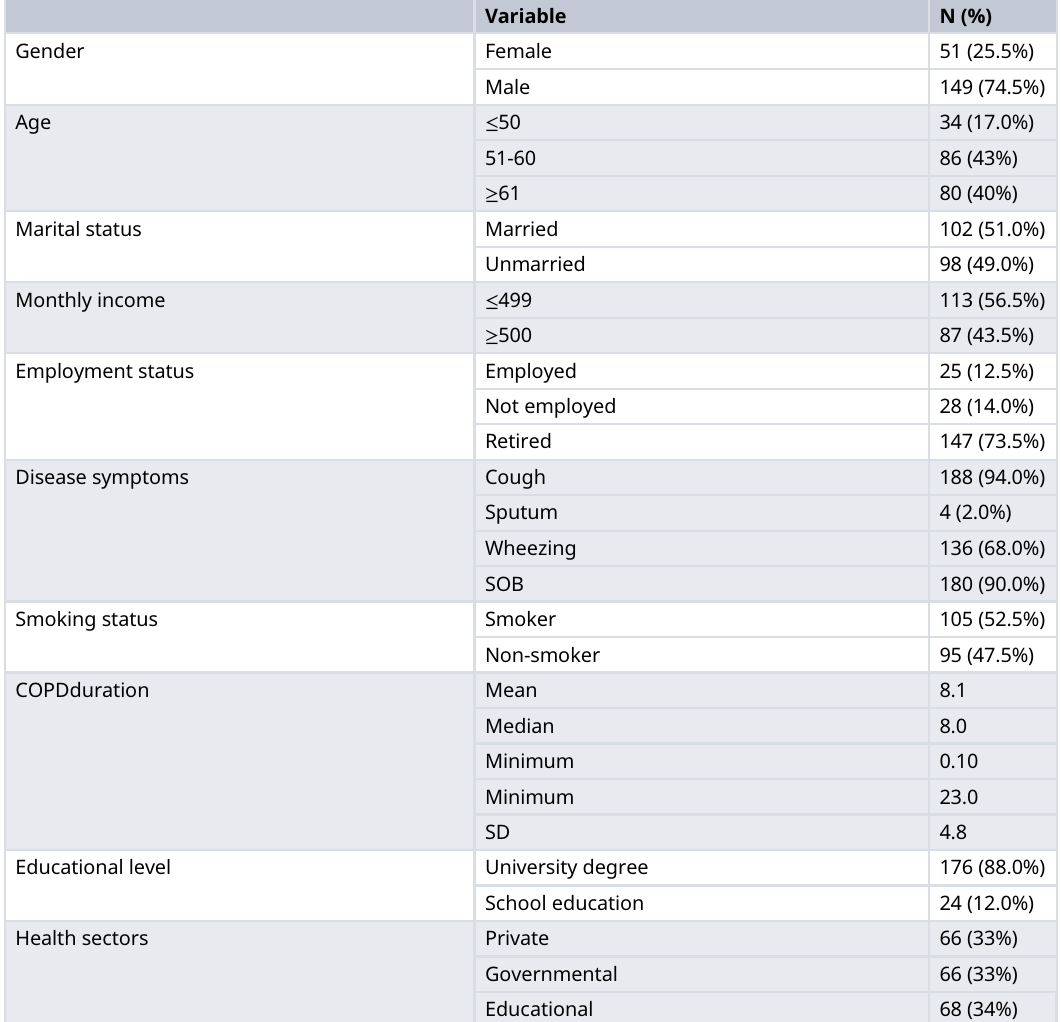
Table 1. Socio-demographic characteristics of the sample